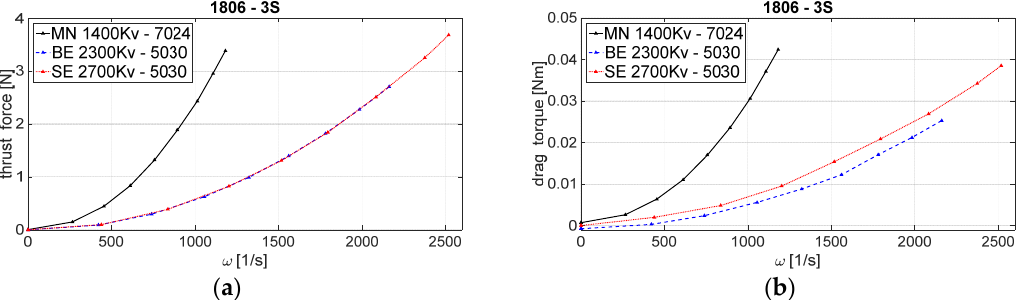
Figure 16. Aerodynamic effects with respect to rotor angular velocity, 1806 BLDC series: ( a ) thrust